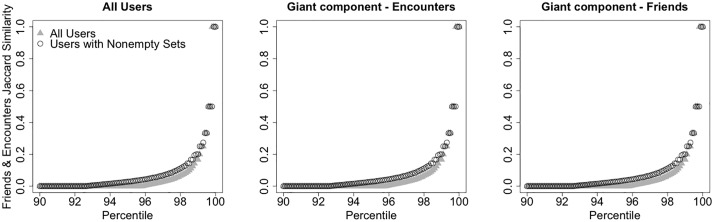
Similarity of friend and encounter sets.Percentile plot of the Jaccard similarity of the set all user’s friends and the set of all user’s encounters. Left: all non-singleton users. Center: users in the giant component of the network defined by all encounters. Right: users in the giant component of the network defined by all friendship ties.